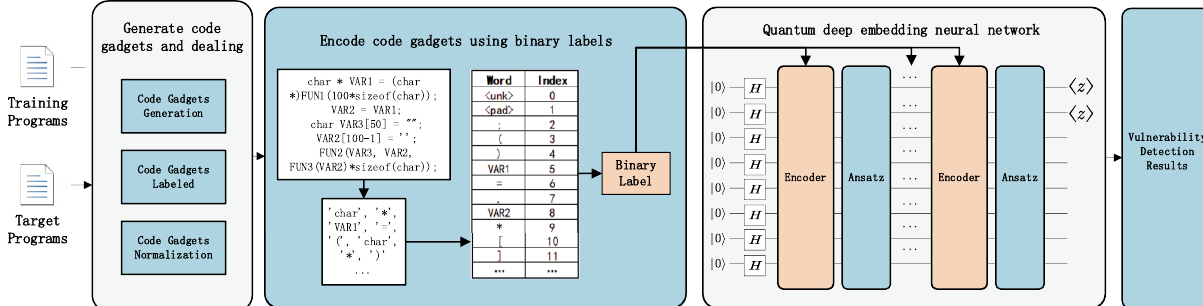
Figure 1. The framework for using a quantum neural network to detect vulnerabilities. The centre represents the overall structure of the three parts. (a) Generating and dealing with code gadgets. Generate code gadgets by slicing the relevant code according to the API functions and dealing with standardized processes. (b) Encoding code gadgets using binary labels. The code gadgets are encoded using binary labels, and the obtained word vector is used as the input to the quantum neural network. (c) Quantum deep embedding neural network. The value of each word vector is encoded in the quantum neural network. Based on quantum circuit simulation, the probability result of vulnerability detection is finally output through